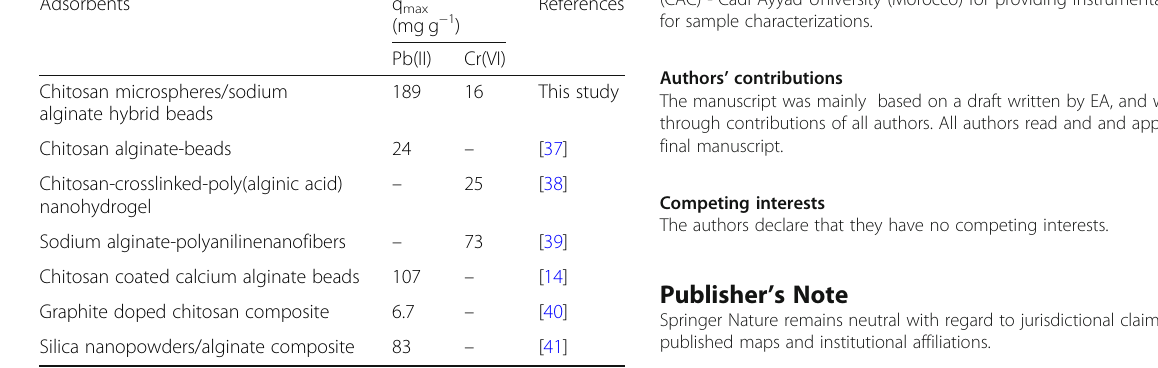
Table 3 Maximum adsorption capacity of different adsorbents based biopolymers used for the removal of Pb(II) and Cr(VI)